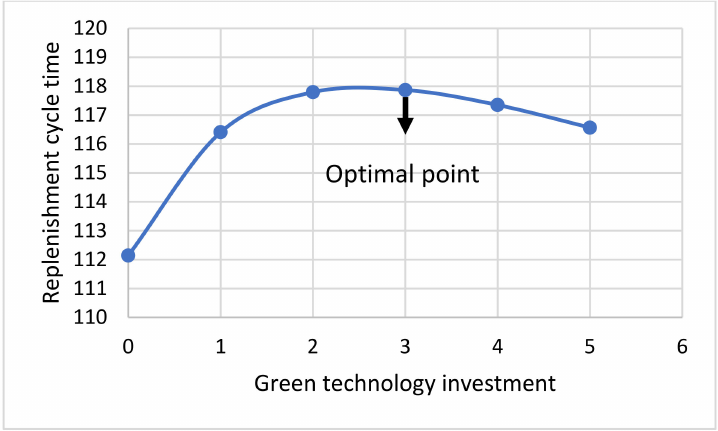
Figure 5. Impact of green technology investment on total profit when T > S